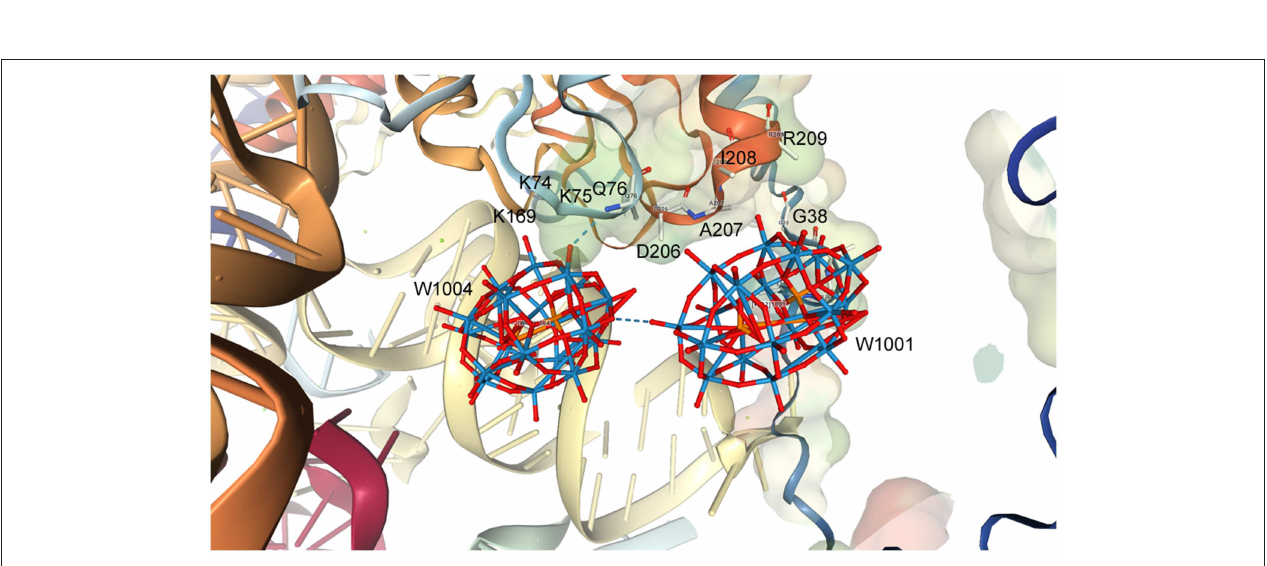
FIGURE 6 | The structure of a representative Double Wells-Dawson cluster consisting of clusters 1,001 (Right) and 1,004 (Left) from 1 I 94.